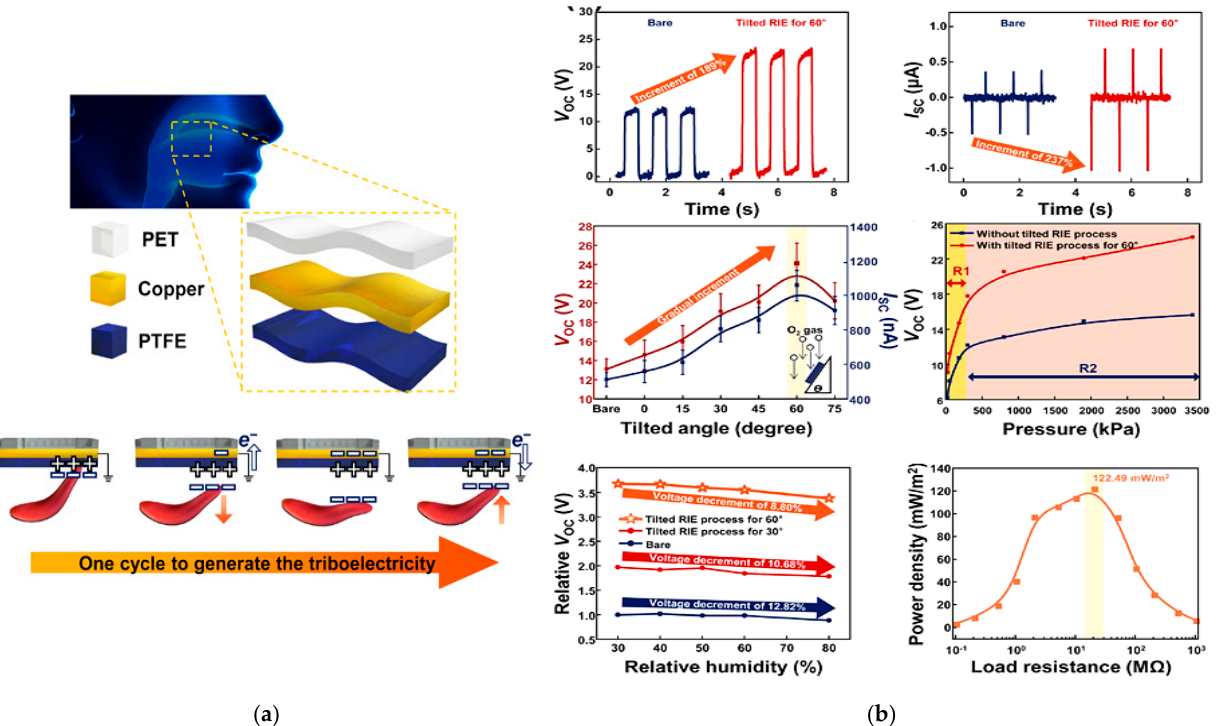
Figure 11. Schematic illustration of fabricated TSR and the working mechanism in one operating cycle ( a ). Open circuit voltage and short circuit current measured on TSR–B and TSR–T60, including the tension produced when the tilting varies, the pressure sensitivity of both the sensors, the output voltage when the humidity increases up to 80%, and the power density according to the load resistors ( b ) [33]. Table 4. Specification comparison of analyzed rehabilitation monitoring systems.